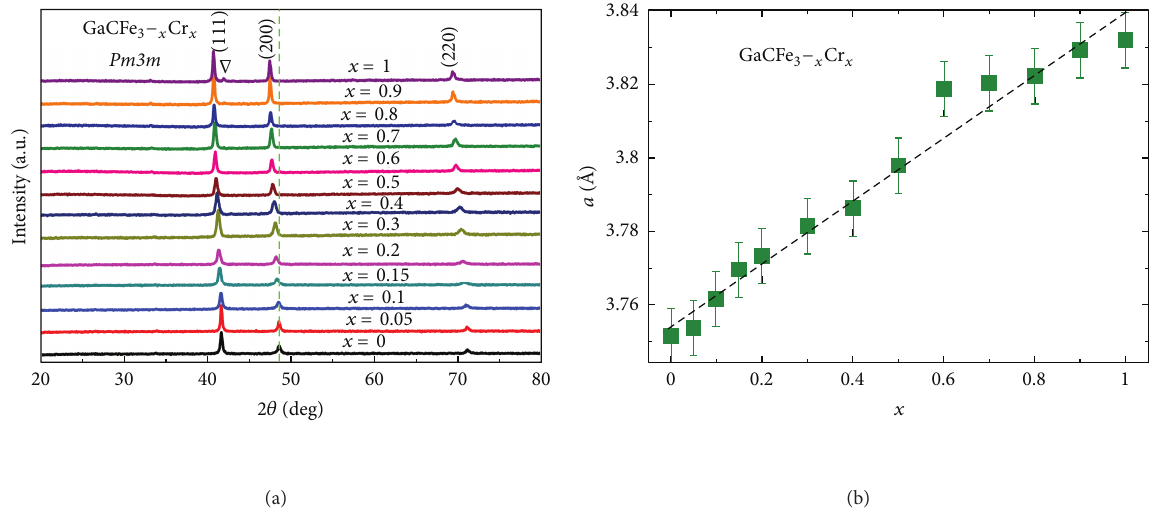
are single phase with a cubic antiperovskite structure (space 𝑥𝑥 group: Pm 3 m ) except for a small amount of chromium (marked by open triangle) for . Moreover, according to the vertical bars the central position of peak (200) of shis to lower angles with an increase of Cr content , suggesting that the lattice constant expands with . e Rietveld re�nements of XRD patterns were performed for all samples to determine the lattice